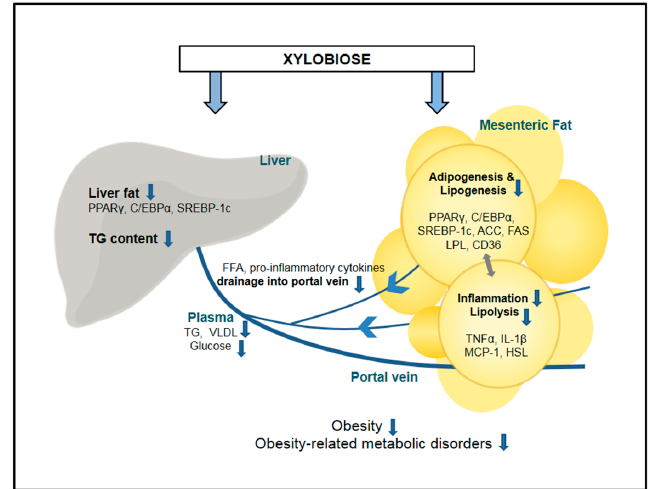
Figure 5. Proposed mechanism of xylobiose-regulated metabolic changes in obesity. Xylobiose suppresses adipogenesis, lipogenesis, lipolysis, and inflammation in mesenteric fat, and this reduces the release of FFAs and inflammatory cytokines to the portal vein. As a result, fat accumulation in the liver is suppressed. ACO, acyl-CoA oxidase; CD36, cluster of differentiation 36; C/EBP α , CCAAT/enhancer binding protein alpha; FAS, fatty acid synthase; FFA, free fatty acid; HSL, hormone-sensitive lipase; IL-1 β , interleukin 1 beta; MCP-1, monocyte chemoattractant protein-1; LPL, lipoprotein lipase; PPAR γ , peroxisome proliferator-activated receptor gamma; SREBP-1c, sterol regulatory element-binding protein 1; TG, triglyceride; TNF α , tumor necrosis factor alpha; VLDL, very low-density lipoprotein.